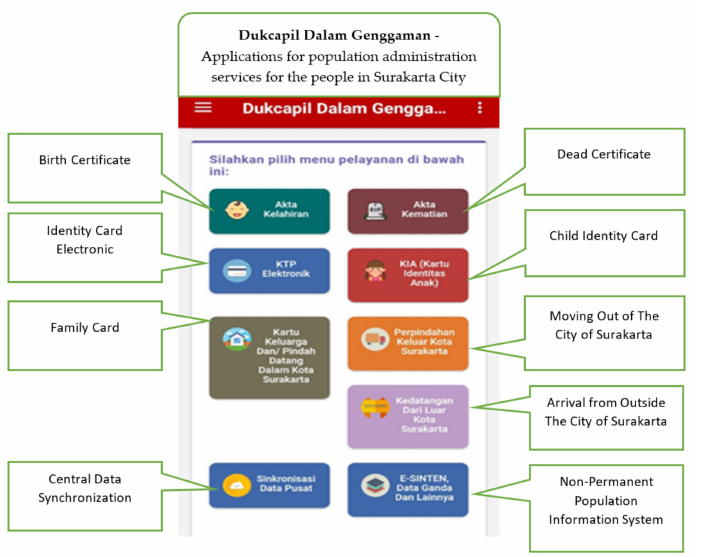
Figure 7. The “Dukcapil Dalam Genggaman” application. Source: Researcher’s